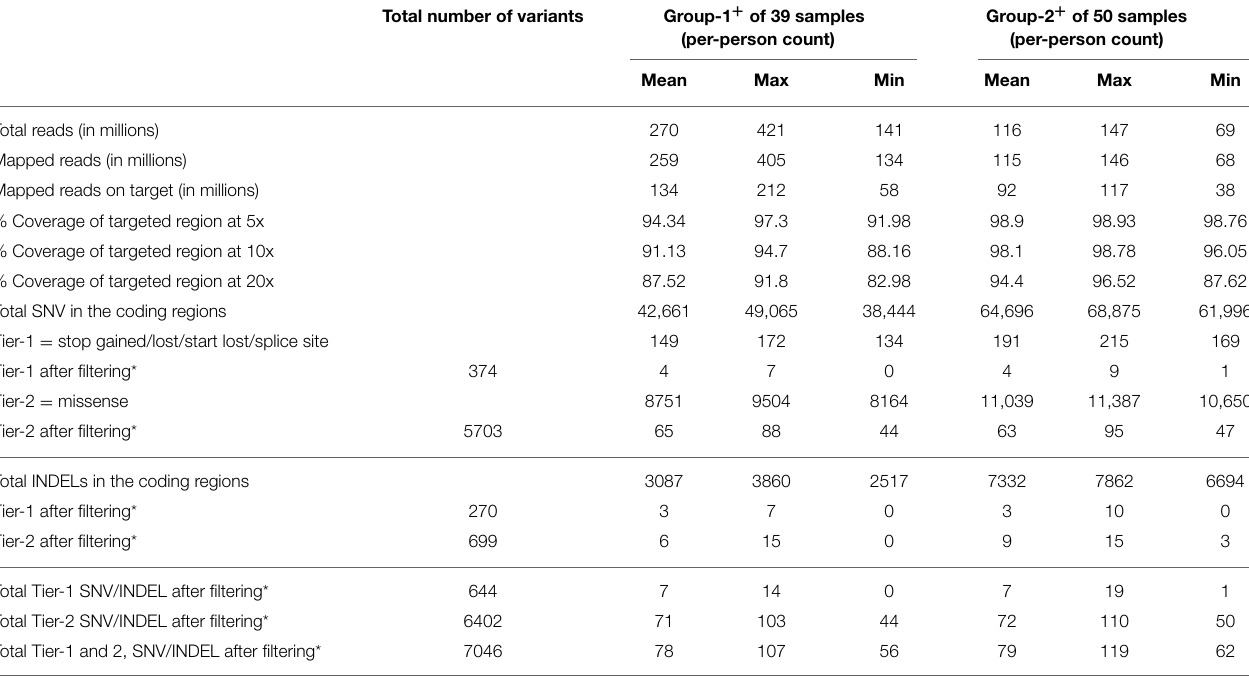
TABLE 1 | Number of reads and variants per sample from the 89 WES